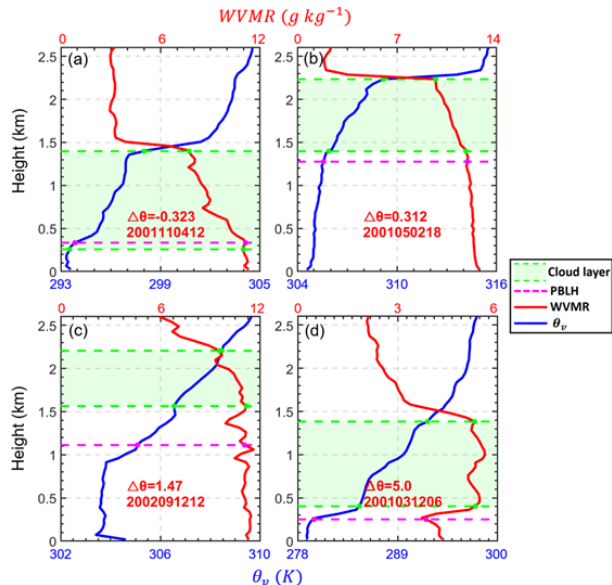
Figure 2. Virtual potential temperature ( θ v , blue lines) and water vapor mixing ratio (WVMR, red lines) profiles from radiosonde (RS) over the Southern Great Plains site for different cases. The differences in virtual potential temperature between the cloud base and the planetary boundary layer (PBL) top are expressed as (cid:49)θ v ( θ CBH v − θ PBLH v ). The time of each radiosonde launch is marked in each panel as “YYYYMMDDHH”, where YYYY, MM, DD, and HH indicate the year, month, day, and local time, respec- tively. Green regions are cloud layers, and dashed green lines in- dicate their boundaries. The cloud layer is obtained from the CLD- TYPE/ARSCL data. PBLHs is derived from RS data and is marked as dashed pink lines.